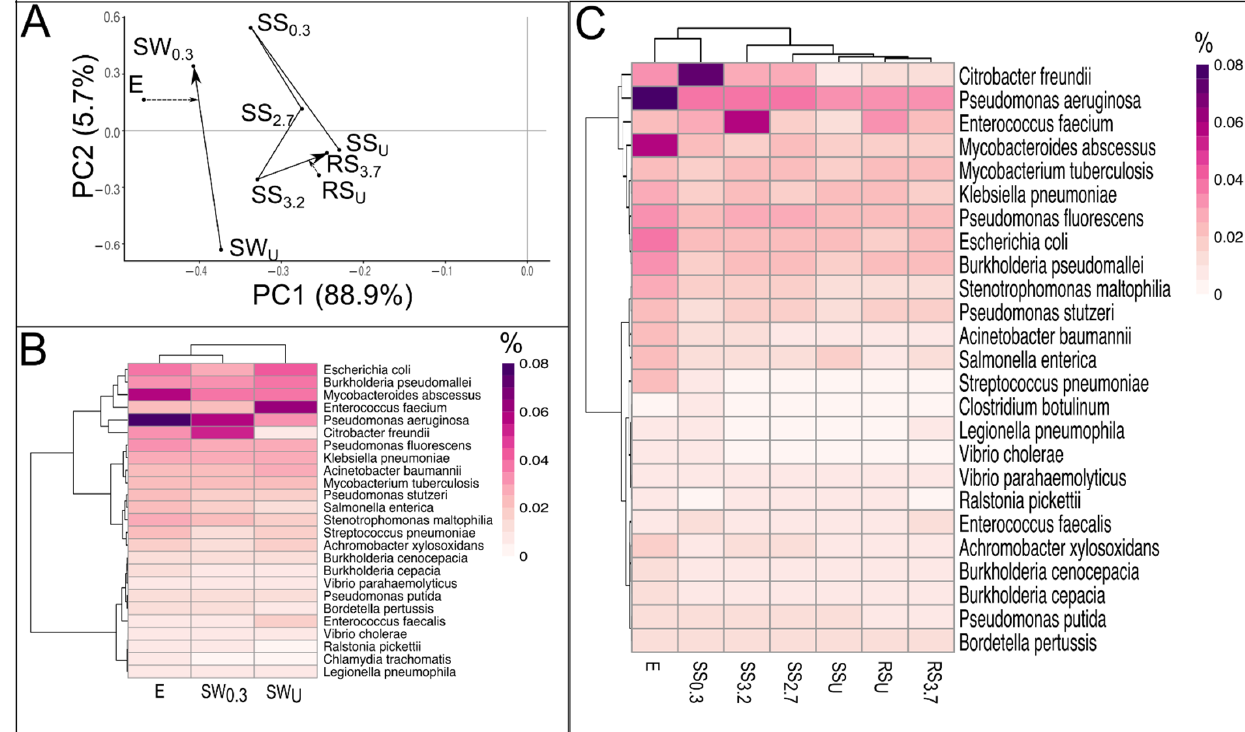
Figure 5. A plot based on a principal component analysis ( A ) showing ordination of the samples according to the proportions of pathogens in the bacterial communities. Solid lines connect samples along the distance gradient, and dashed lines depict the effect of E and RS U . Heatmaps showing clustering of the water and sediment samples ( B , C , respectively) according to their proportions (%) of the top 25 pathogens in the bacterial communities. E is the effluent of the wastewater treatment plant (WWTP), SW and RW are the water samples and SS and RS are the sediment samples of the stream and river, respectively. SW U and SS U are the sediment samples taken upstream of the WWTP discharge point, and RW U and RS U are the samples taken from the river upstream of the stream inflow point. The number in the subscript of the sample code shows the distance (km) of the sampling point downstream from the WWTP discharge point.